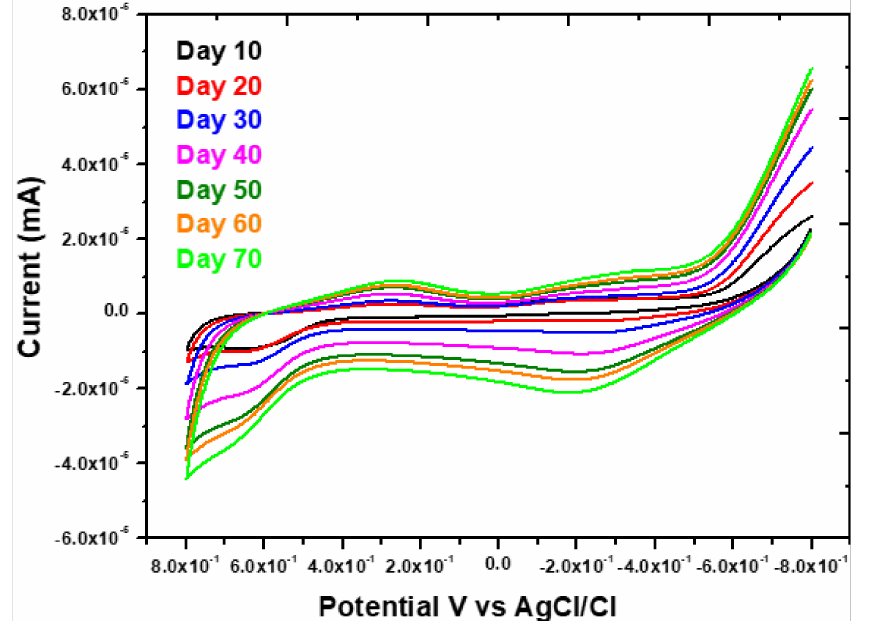
Figure 4. CV studies of this operation at different time interval. Table 2. Cp values of the present